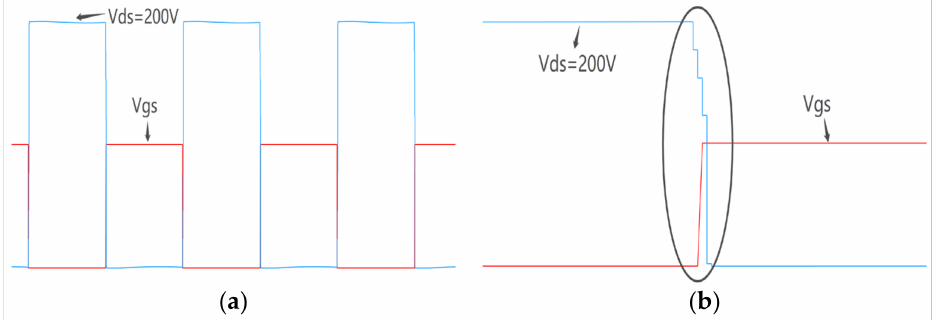
Figure 7. Simulation results for fs = 125 kHz: ( a ) Steady-state waveforms (time scale: 4 µ s/div); ( b ) partial amplification waveforms (time scale: 800